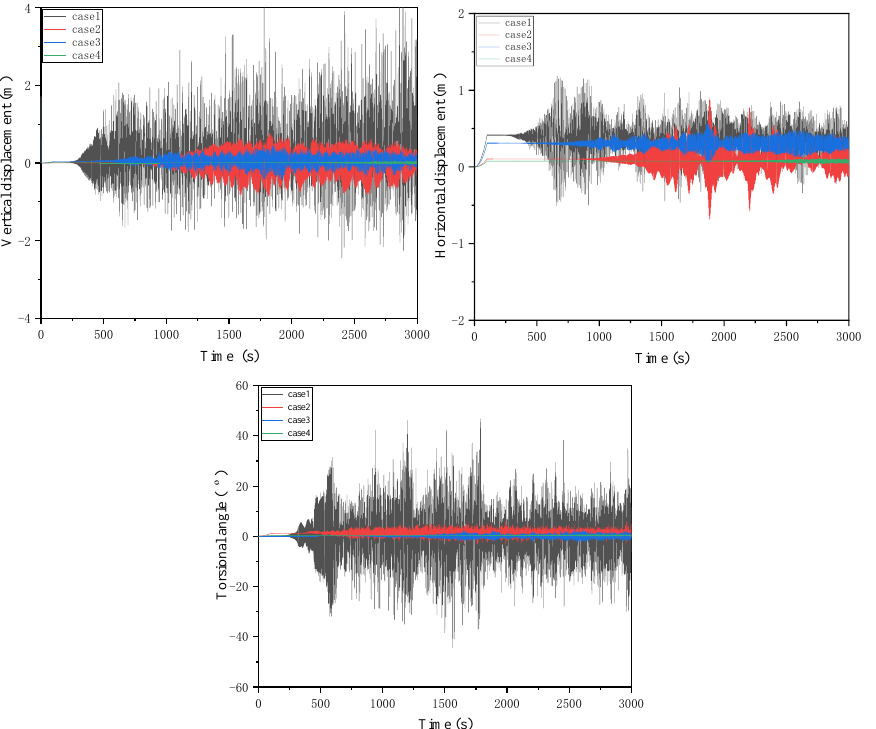
Figure 10. Galloping situation of conductor under different wind velocities and different initial angle of attack.